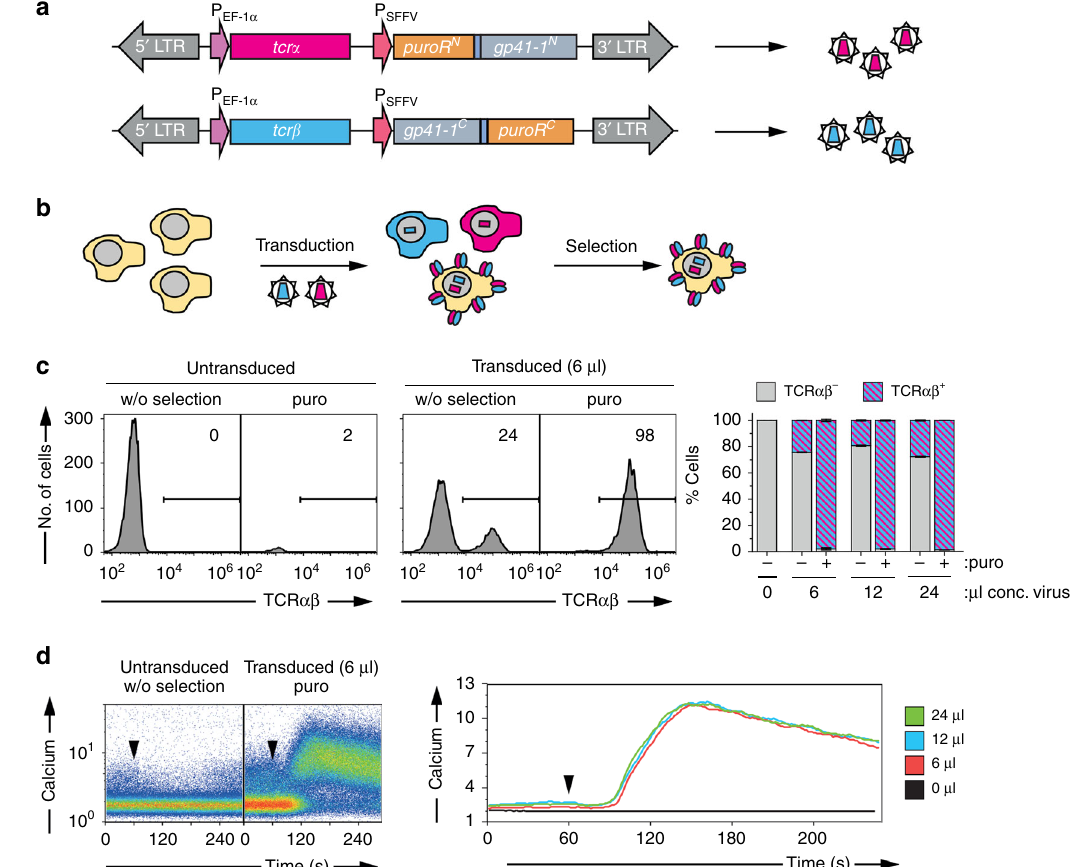
Fig. 9 SiMPl allows selecting functional Jurkat T cells expressing a murine TCR on their surface. a Schematic of the SiMPl lentiviral vectors encoding TCR α and TCR β where the puromycin acetyltransferase is split at position V82:E83. b Schematic of the work fl ow. c TCR α - TCR β - Jurkat T cells selected on puromycin after transduction with the two lentiviruses in ( a ) are 100% positive for the TCR. Left panel, representative histograms of living cells gated using forward versus side scatter and propidium iodide staining. Numbers indicate the percentage of cells expressing murine TCR β on their surface (TCR αβ indicates that TCR α must be expressed to allow presentation of TCR β on the cell surface). Right panel, stacked bar chart showing the percentage of TCR αβ + cells for the indicated conditions. Values represent mean (± standard deviation) of three independent experiments. Standard bar graphs with individual data points are shown in Supplementary Fig. 25a. d Selected cells are functional. Intracellular calcium levels after stimulation with anti-murine TCR β antibodies for the indicated cells. Left panel, dot plots of the calcium response depicted as ratio of Fluo-3 to Fura Red fl uorescence over time. Right panel, overlay of the calcium responses of puromycin selected cells transduced with 6, 12 or 24 µ L of concentrated lentivirus. The graph shows the 70 th percentile of the ratio of Fluo-3 to Fura Red fl uorescence over time. Source data are provided as a Source Data fi